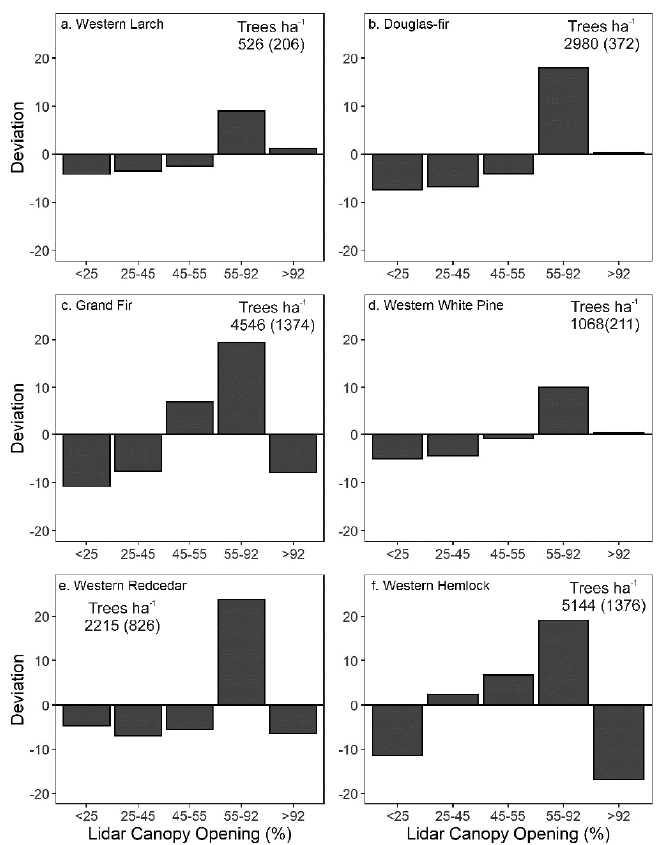
Figure 4. Chi-gram on regeneration establishment across a range of canopy opening sizes for six conifer species (( a ) for western larch, ( b ) for Douglas-fir, ( c ) for grand fir, ( d ) for western white pine, ( e ) for western redcedar, and ( f ) for western hemlock) using management thresholds identified by Jain et al. (2004). Chi-grams illustrate expected versus observed. Expected values are 0 compared to the observed deviation which are either equal to the expected or more or less abundant than the expected. Chi-square goodness-of-fit was p = 0.0001. Trees ha − 1 are means and standard errors are in parentheses. The influence of site preparation and canopy opening on 5-year height growth varied by